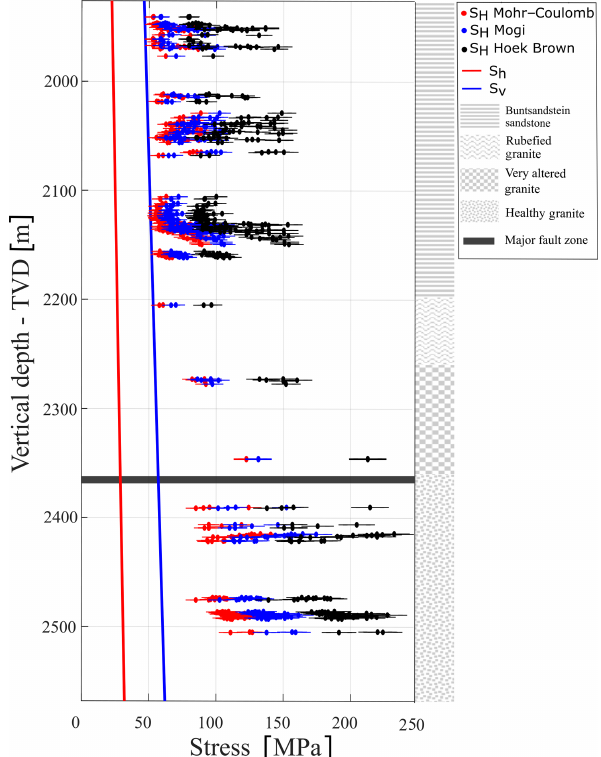
Figure 15. In situ stress state components S h , S v and S H (MPa). Maximum horizontal stresses S H are inverted with three distinc- tive failure criteria for the images acquired in 2013 in GRT-1. Error bars are calculated considering the error on the measurement of the breakout width, on the estimates of the elastic parameters, and on the S h and S v trends. The right column illustrates the four major lithological units retained in the model, and the horizontal band lo- cates the major fault zone crossed by